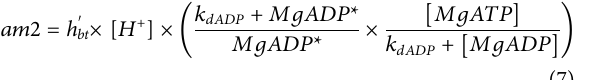
Figure 3B Engineered heart tissues made of hiPSC-CMs on decellularized porcine left ventricular tissue blocks Figure 3D Human β -cardiac myosin Figure 3B, Isolated adult rat ventricular cardiomyocytes Fig. S1 Figure 3D Human β -cardiac myosin, Porcine and Bovine ventricular myosin, mouse cardiac myo fi brils Kawas et al. (2017)